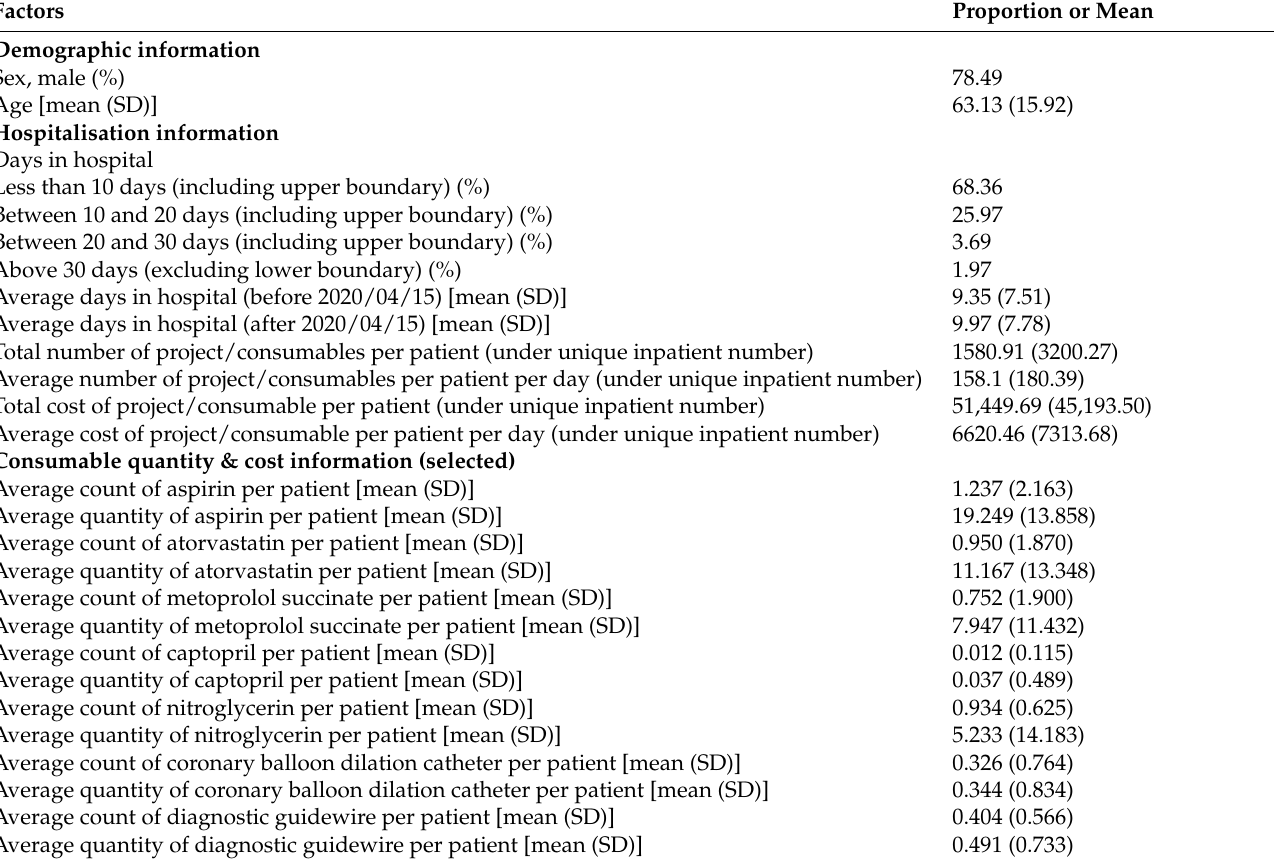
Table 3. Variables of the